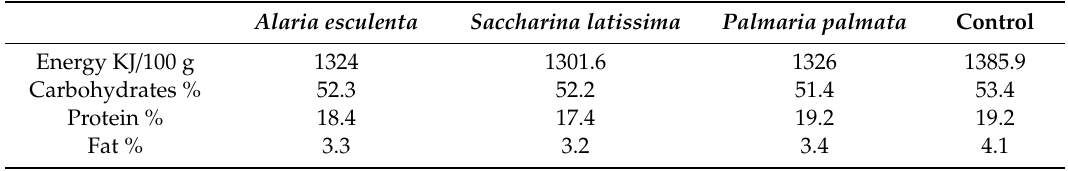
Table 2. The nutritional composition of the four intervention diets. Twenty percent (weight-percent) dried seaweed was mixed with 80% chow (Altromin type 1324, Lage, Germany). The control diet was 100% chow made from the same